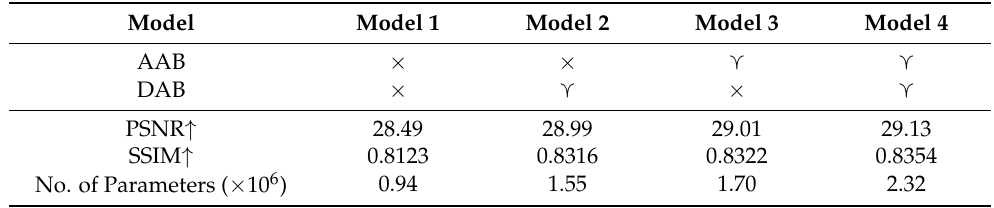
Table 1. Tool-off tests for the effectiveness of AAB and DAB. Each test result provides PSNR (dB), SSIM, and the number of parameters.